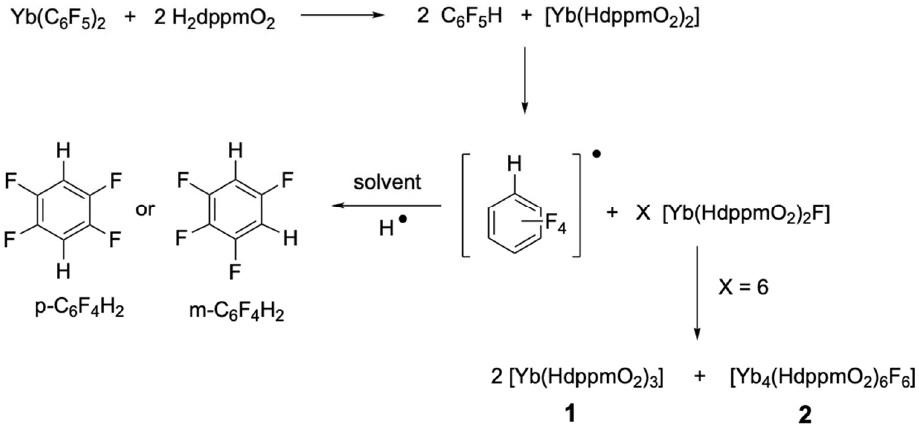
Figure 6. The molecular structure of [Yb 4 ( µ -HdppmO 2 ) 6 ( µ -F) 6 ] 2 . All hydrogen atoms are omitted for clarity except backbone methanide protons. Displacement ellipsoids are drawn at the 30% probability level. The lattice solvents THF and C 6 D 6 have been omitted and phenyl groups drawn in wire frame for better clarity. Symmetry operator = 1 − x,+y,1/2 − z. Selected bond lengths (Å) and bond angles ( ◦ ) can be found in Table